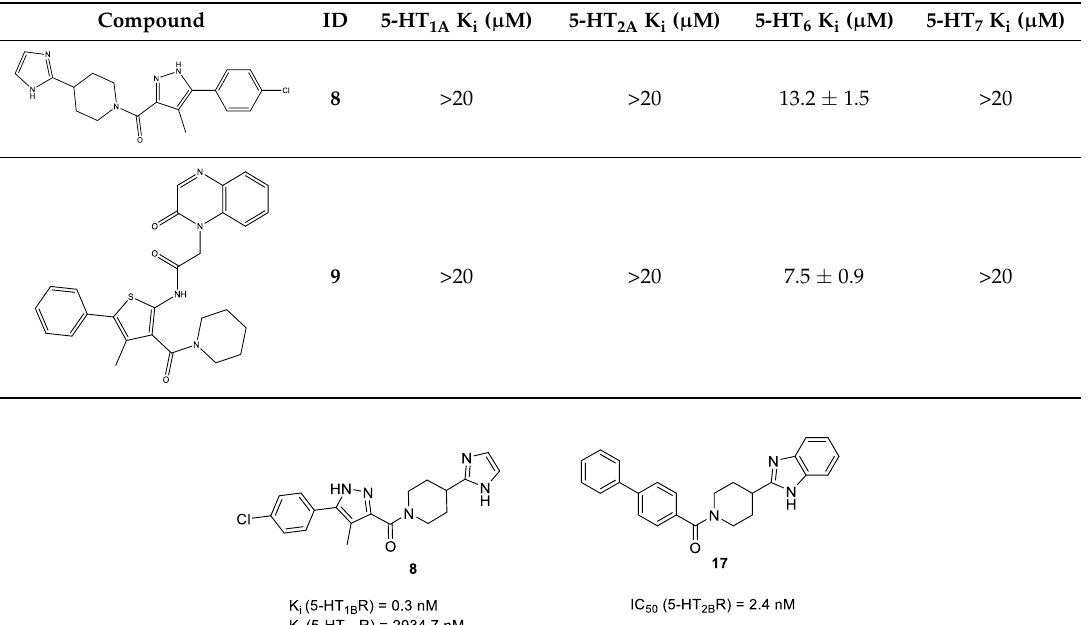
Table 3. 5-HT panel screening of the best hits. Values represent the mean ± SD of three independent assays with duplicate measurements.